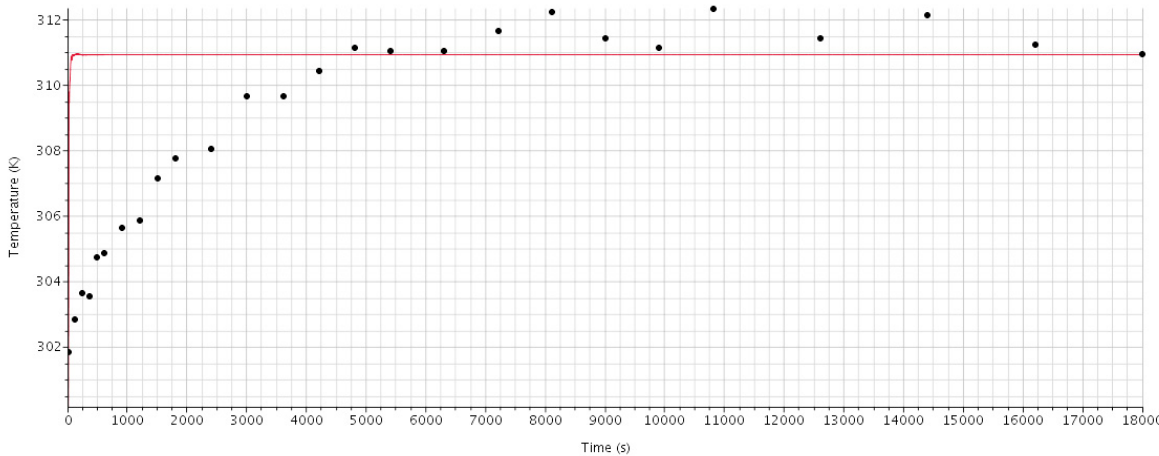
Figure 5. Comparison between experimental and numerical data.